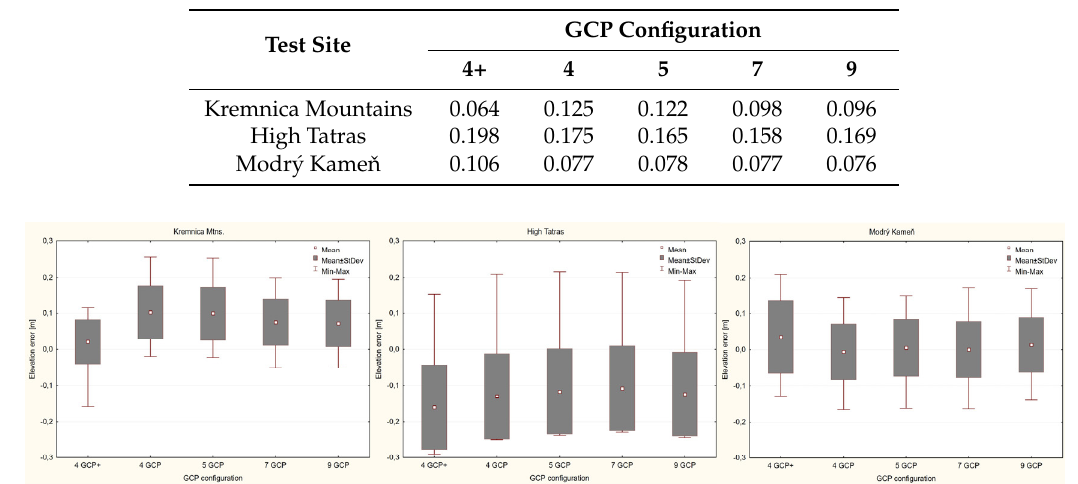
Table 4. Root mean square elevation errors RMSE z according to the test sites and GCP configurations (in metres).